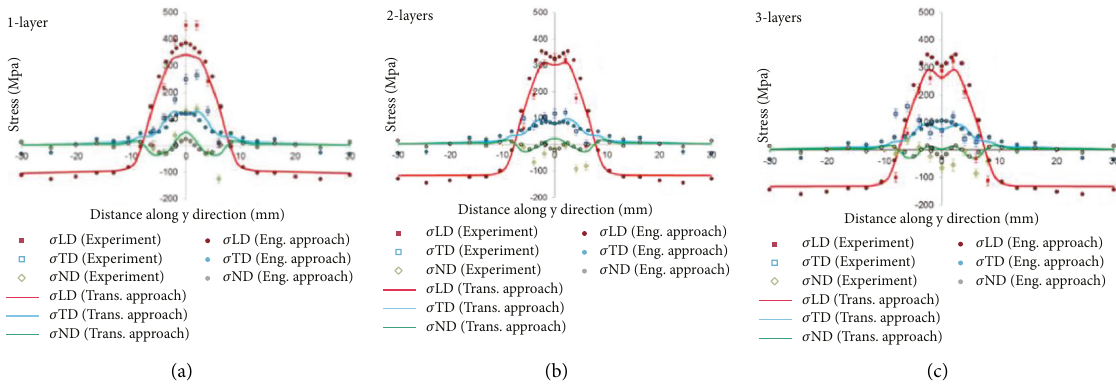
Distance along y direction